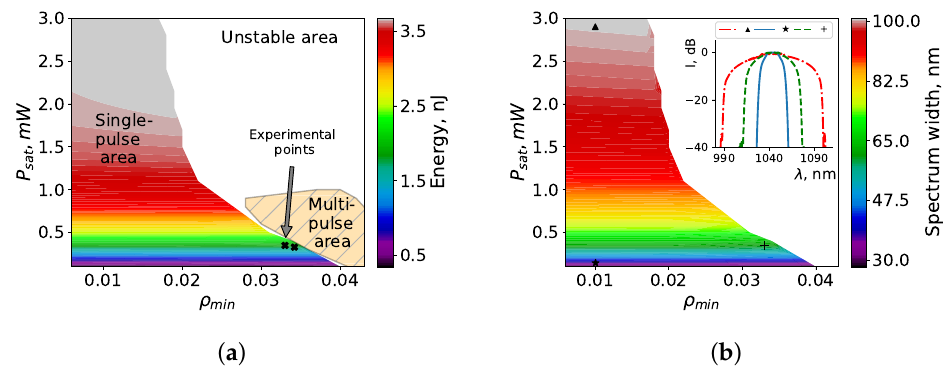
Figure 5. Parameters of the pulses of stable area: energy of single-pulse and multi-pulse areas ( a ) and spectrum width at the level of − 10 dB ( b ). The crosses indicate the regimes corresponding to the experiment. Inset: spectral shapes in points marked by triangle, star, and